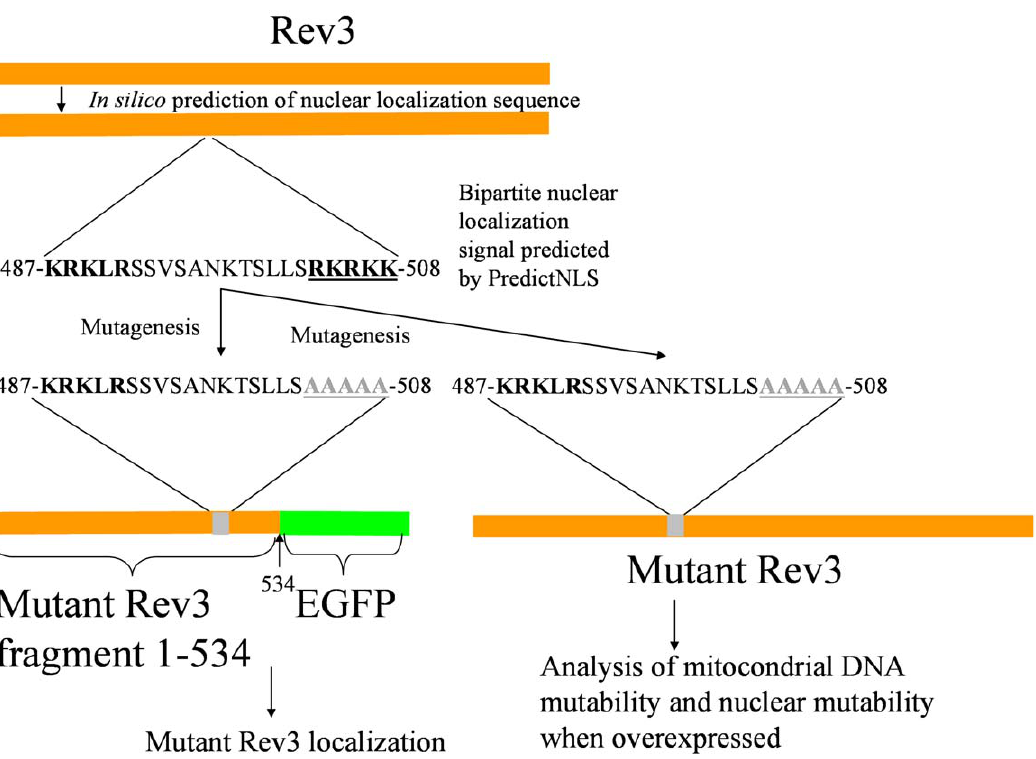
Figure 8. Position and sequence of the bipartite nuclear localization sequence. The stretch RKRKK was mutagenized to AAAAA to obtain a mutant Rev3 fragment fused with EGFP for protein localization and a mutant Rev3 isoform for analysis of mtDNA mutability and nuclear point